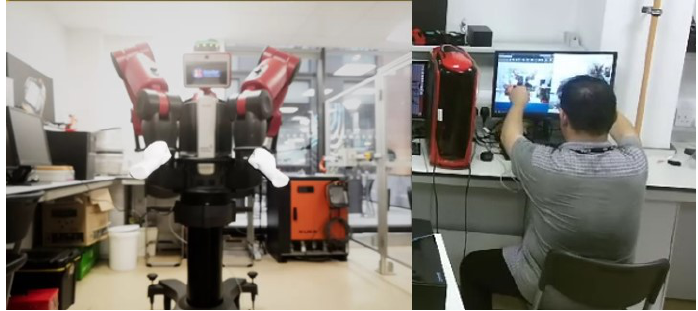
Figure 6. Illustration of the coordinates measurement process under the LeapMotion coordinate